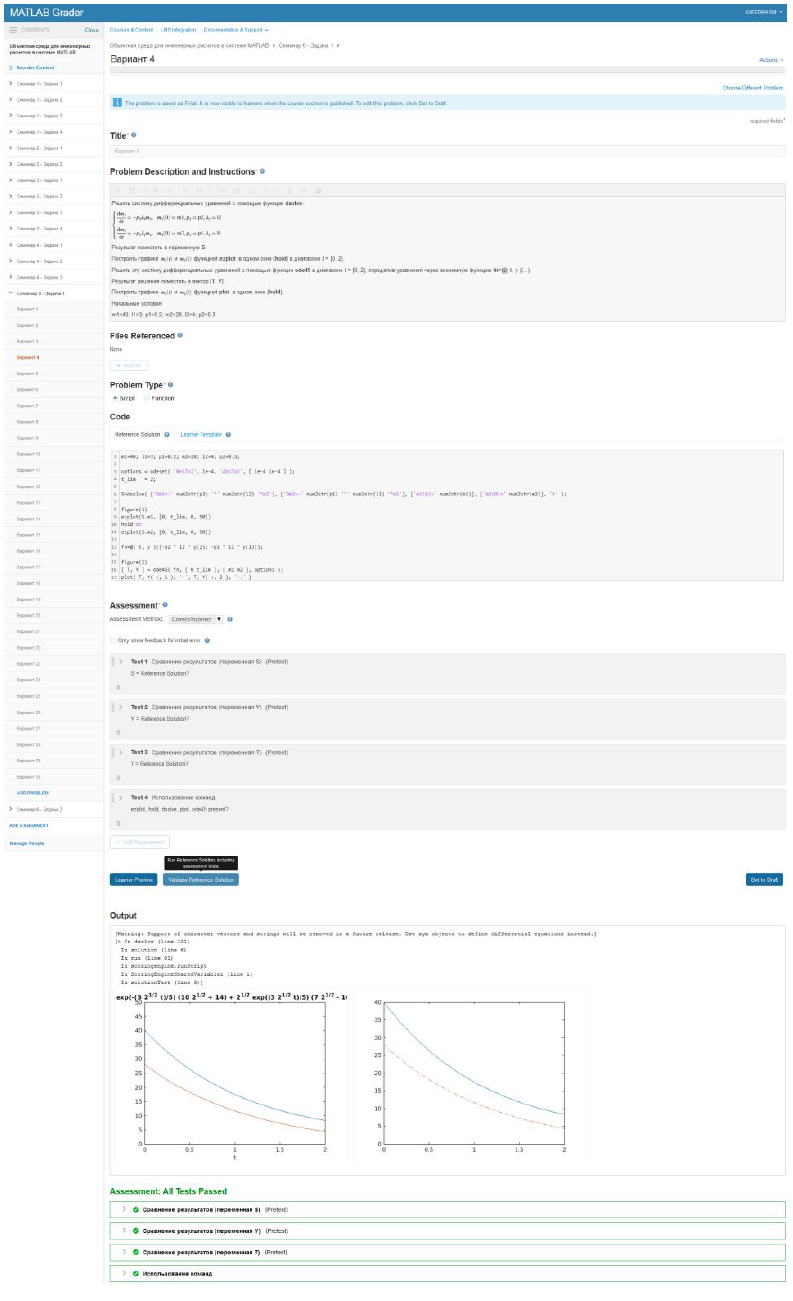
Fig. 5. The example of adding a problem and testing the benchmark solution.